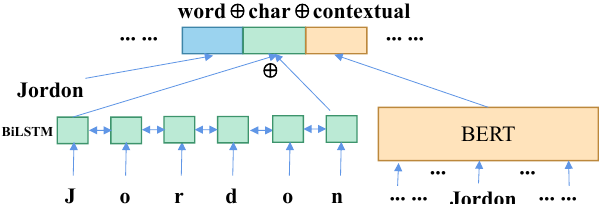
Figure 3. An example to illustrate our final word representation that concatenates its word embedding, char-level representation and contextual BERT